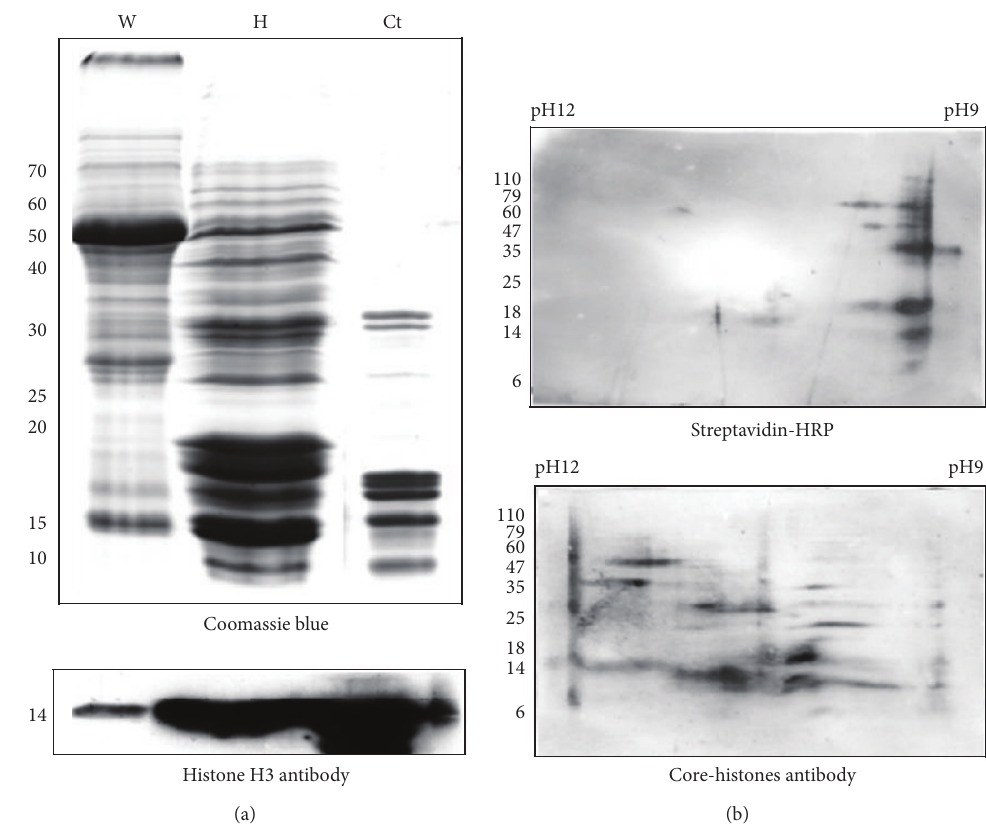
Figure 4: 2D gel analysis. (a) Histone proteins were enriched from Arabidopsis young seedling lysate and stained with Coomassie Blue. The same amount of total and histone-enriched proteins was separated by 15% SDS-PAGE and the western blot results showed that histone proteinswereenrichedfrom Arabidopsis youngseedlinglysate.W:thetotalisolatedproteins.H:thehistone-enrichedproteins.Ct:commercial calf thymus histones (Sigma). (b) The histone-enriched proteins were analyzed by 20% SDS-PAGE with pH gradient from 9 to 12. The biotin signals that concentrate at pH 9 versus the core-histones signals that distribute between pH 10 to 11. Experiments were conducted in